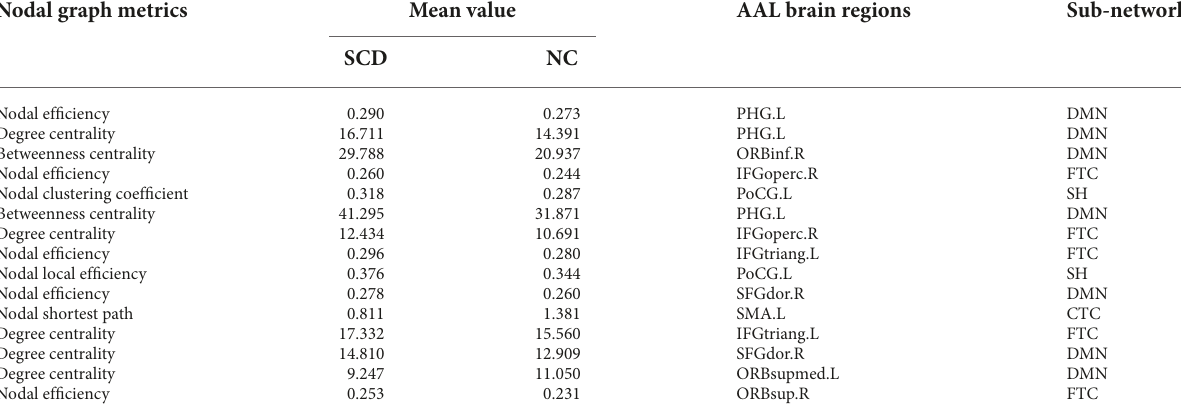
TABLE 3 Top 15 most discriminative nodal graph metrics.